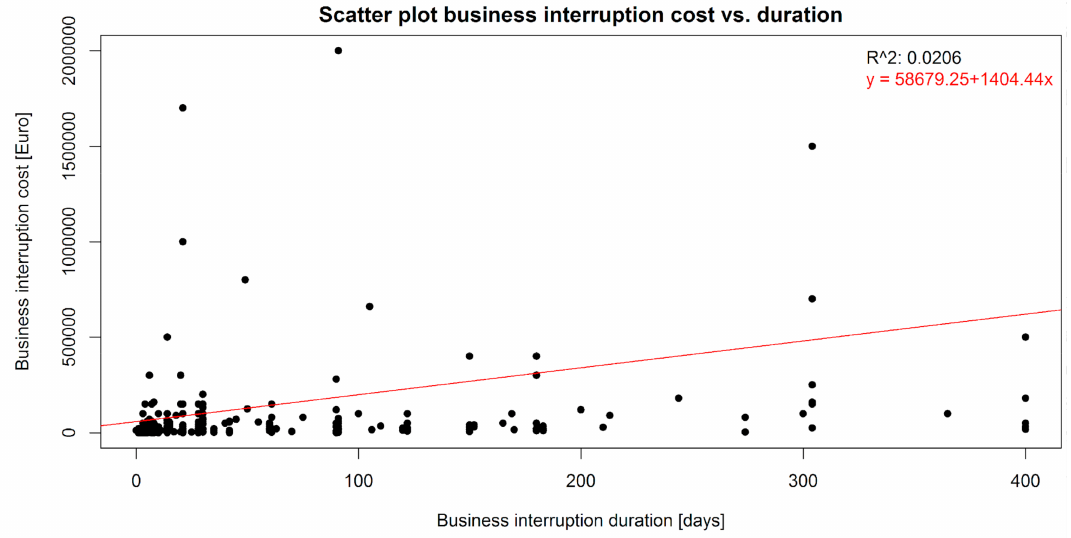
Figure 3. Scatter plot of business interruption cost vs. business interruption duration, with the regression